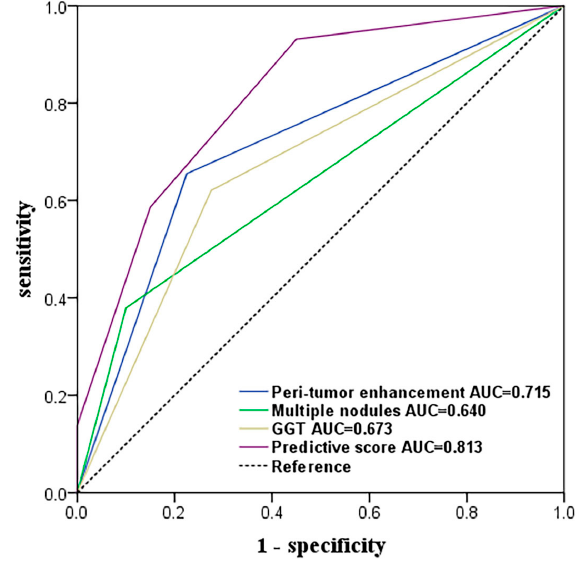
Figure 2. Receiver operating characteristic curves of each independent factor and the prediction score for the prediction of MVI. For the prediction of MVI, the AUC of the prediction score was higher than that of the presence of peri-tumor enhancement ( p = 0.053), GGT ( p = 0.004) and multiple nodules ( p < 0.001).